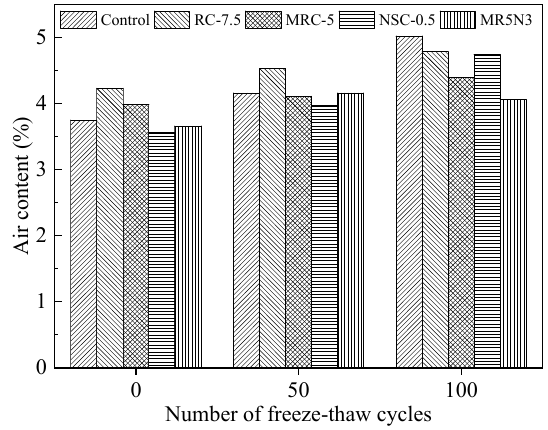
Figure 13. Influence of freeze–thaw cycle on air content.